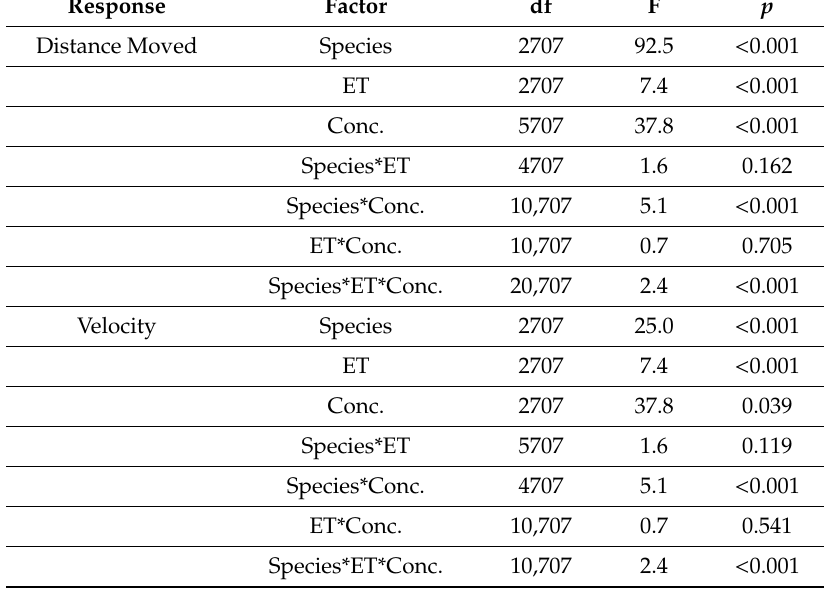
Table 1. ANOVA (Proc Mixed, SAS) for main e ff ects species ( R. dominica , C. ferrugineus , S. oryzae ), exposure time (1, 24, or 72 h, Exposure Time (ET), and concentration of the experimental formulation (Conc.) consisting of methoprene, deltamethrin, and a piperonyl butoxide synergist. Concentrations were 10%, 25%, 50%, 75%, and 100% of the application rate of 1138 mL of the formulation per 27,273 kg of wheat (see description for dilution of concentration in Materials and Methods). Response variables were distance moved (cm) and velocity (cm /